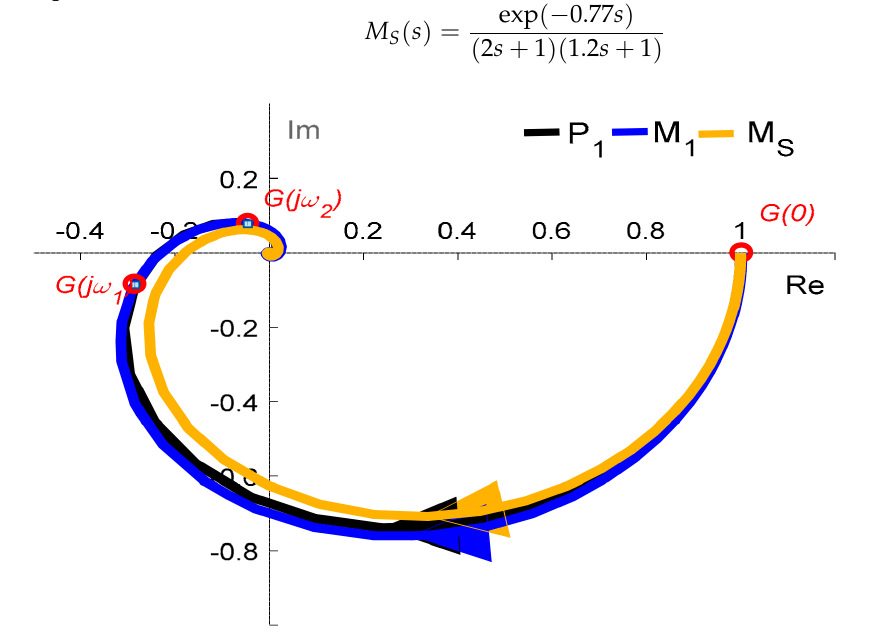
Figure 7. The Nyquist frequency plots of transfer functions P 1 ( s ), M 1 ( s ), and M S ( s ). The model M S ( s ) was derived by Skogestad [22] directly from (18) using the half rule. The unit step responses of process P 1 ( s ), model M 1 ( s ), and model M S ( s ) are shown in Figure